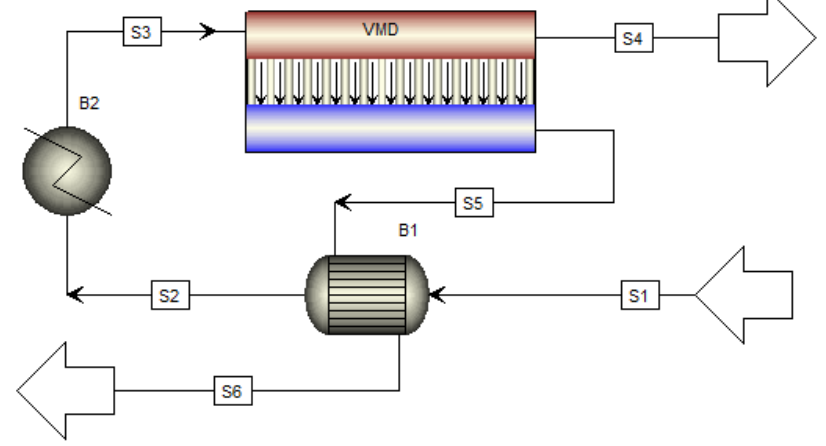
Figure B 1. Flowchart of a base case VMD-based desalination process. Figure A4. Flowchart of a base case VMD-based desalination